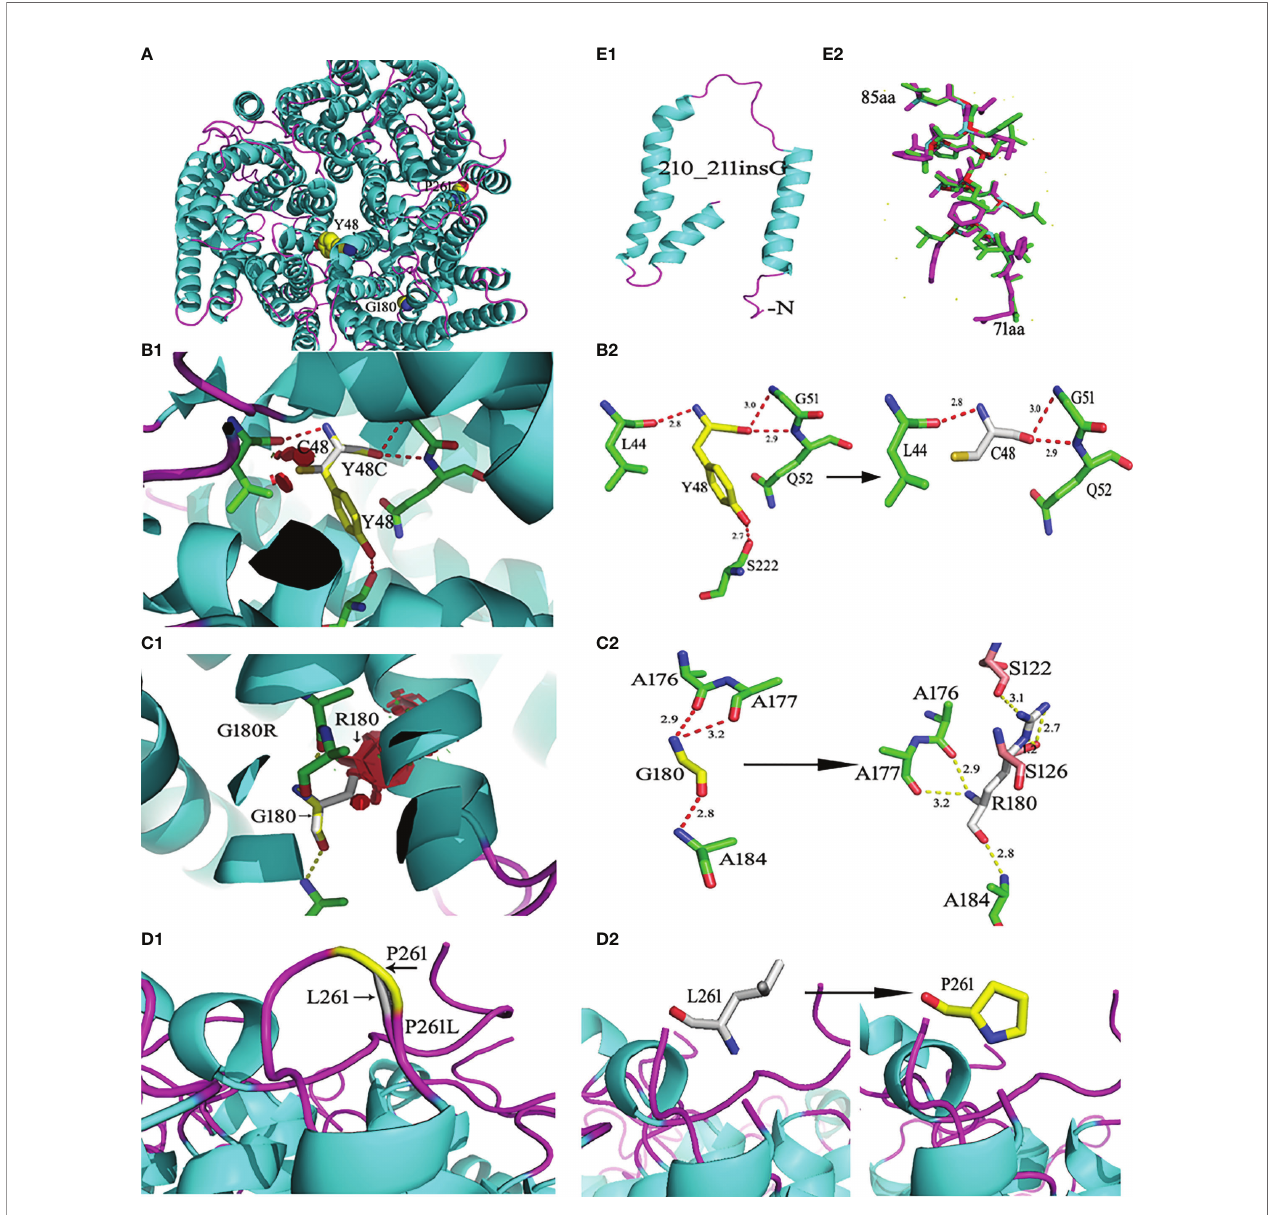
FIGURE 2 | Ribbon diagrams of the wild-type and mutant RhD proteins. RhD proteins were generated from the crystal structure of the RhCG protein (Protein Data Bank accession code 3HD6) template by the SWISS Model. (A) Structures of the wild-type RhD and the amino acid residue position with the point mutation. (B1) The p.Y48C mutant RhD proteins. (B2) The side chain comparison of wild-type Y48 and mutant C48. The dotted line indicates the hydrogen bonds between the amino acid. The number represents the length of the hydrogen bond. (C1) The p.G180R mutant RhD proteins. (C2) The side chain comparison of wild-type G180 and mutant R180. (D1) The loop structural comparison of wild-type RhD and mutant p.P261L protein. (D2) The amino acid P261 and substitution L261 were shown by stick. (E1) The C- terminally truncated RhD protein caused by c.210_211insG. (E2) Fourteen frameshift amino acids from 71 to 85 positions. The purple-red sticks represent the amino acids in the wild-type Rh protein, and the green sticks represent the amino acids in the mutant protein. The mutations were generated using PyMOL